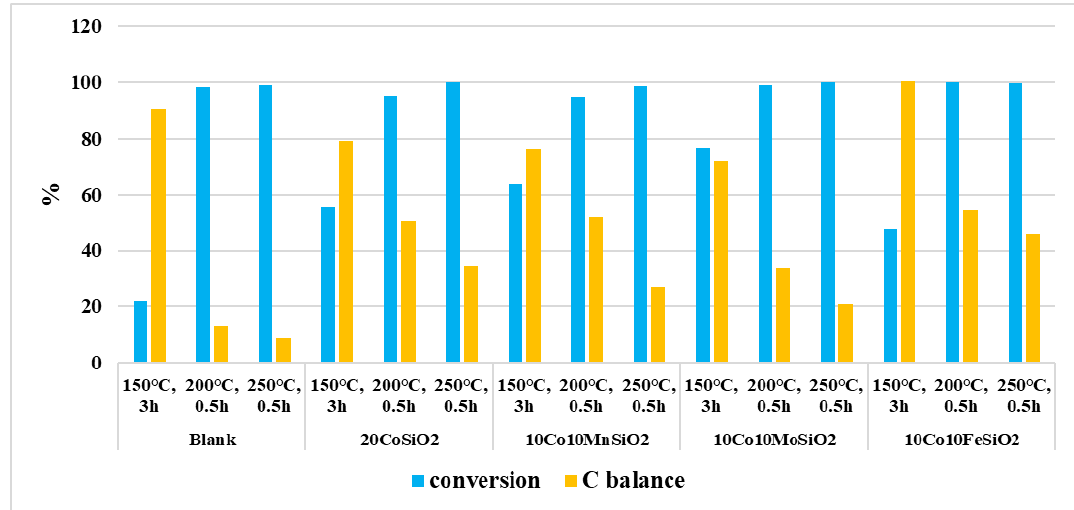
Figure 5. Glucose conversion and carbon balance in the presence of catalysts.